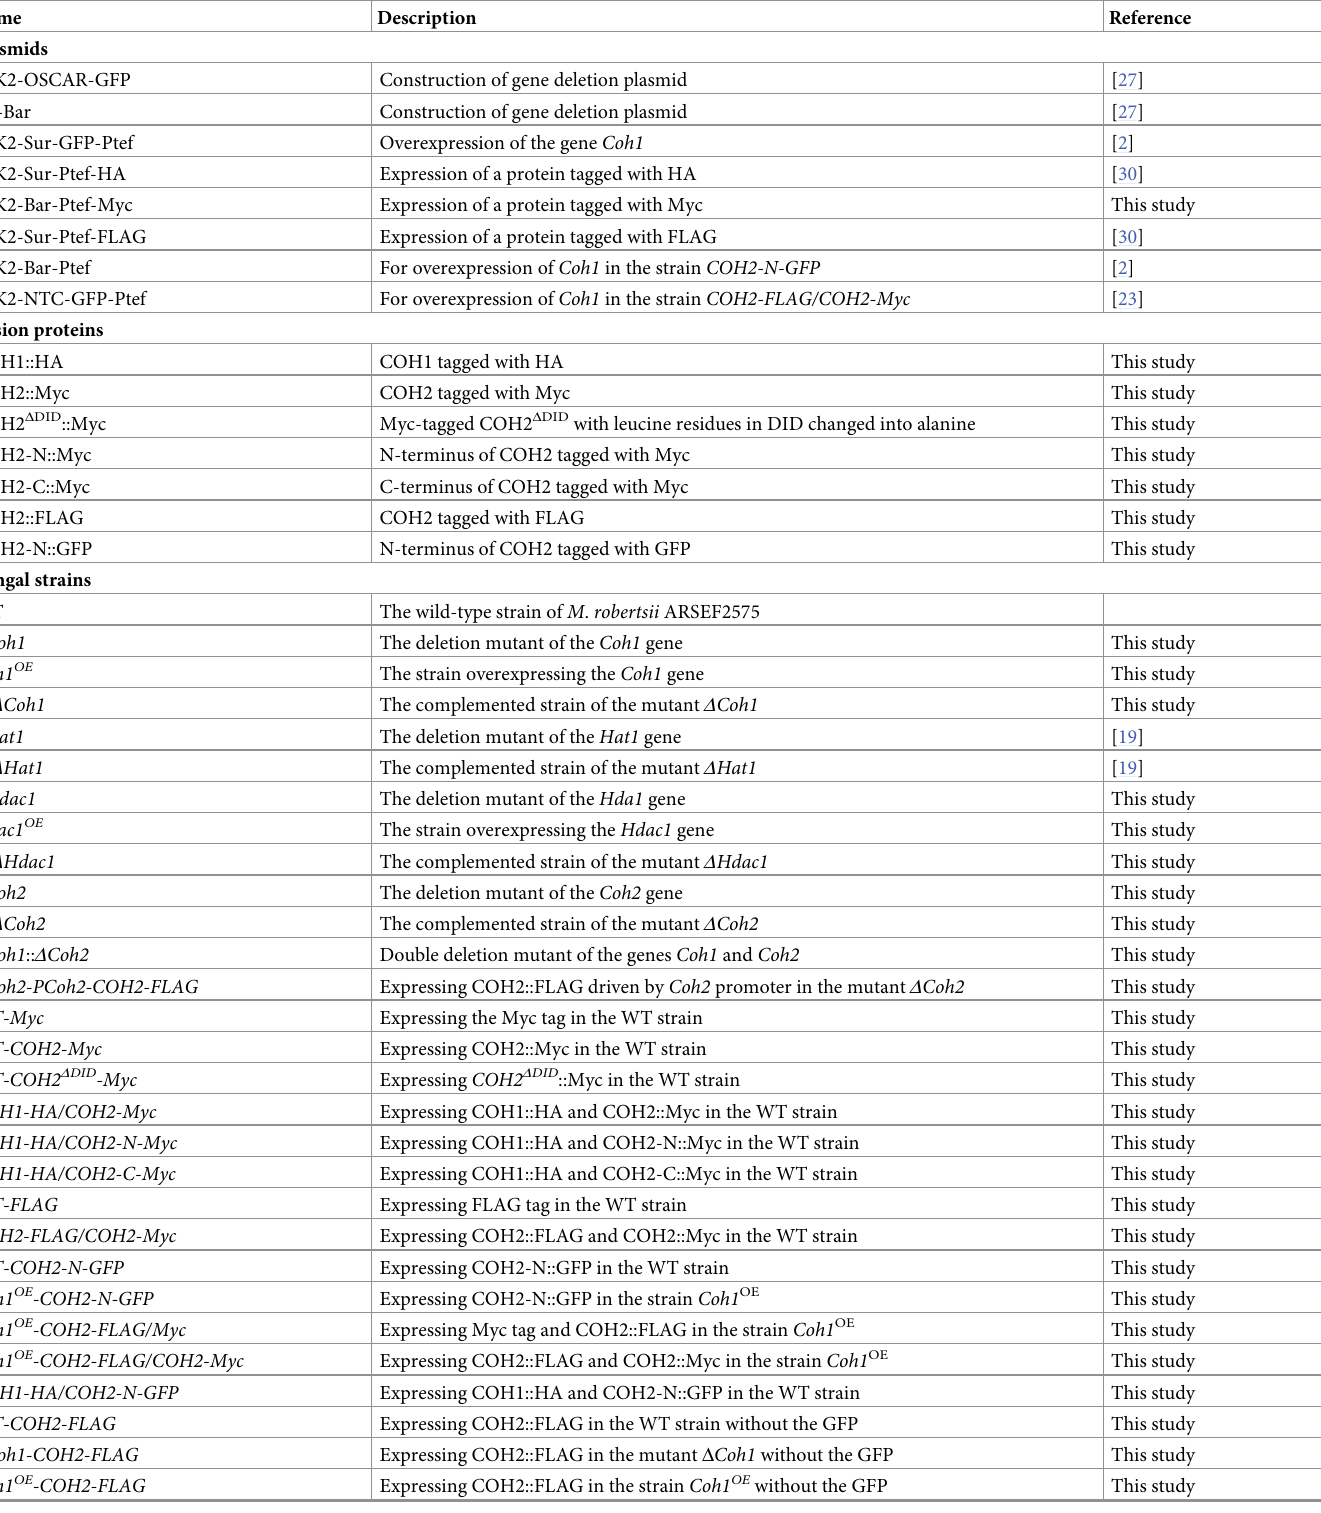
Table 1. Plasmids, fusion proteins, and fungal strains used in this study AU : ThestrainsWT (cid:0) COH 2 (cid:0) FLAGand D Coh 1 (cid:0) COH 2 (cid:0) FLAGeachoccurtwiceinTable 1 ; withdifferentdescriptions : Ifthisisnotasintended ; pleaseeditasnecessary :